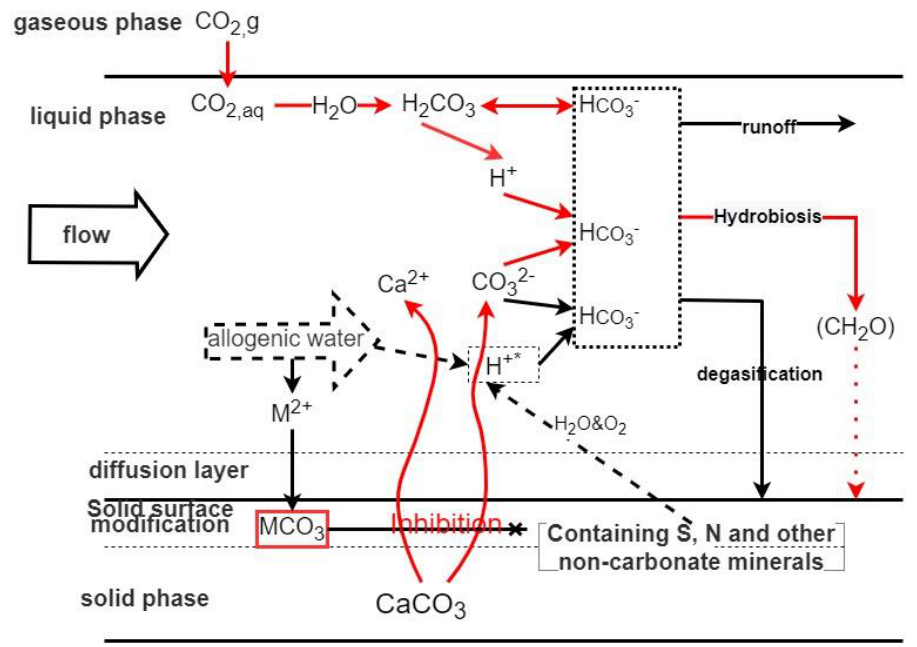
Figure 13. Kinetics of calcite group carbonate dissolution in a solid − liquid − gas three − phase sys- tem.